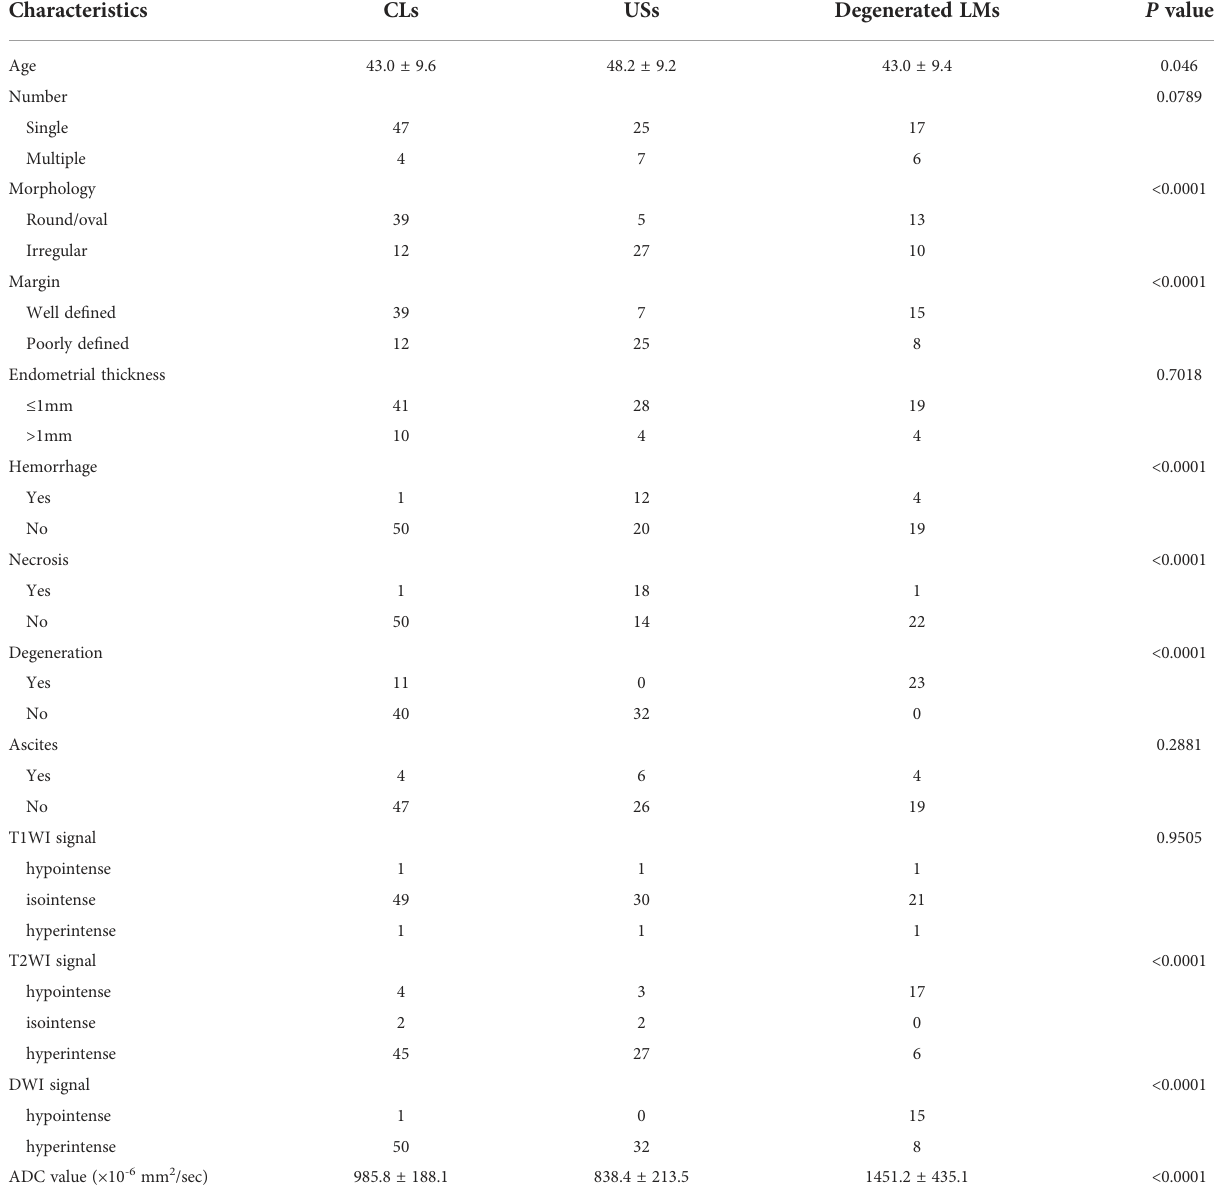
TABLE 1 Comparisons of clinical demographics, conventional MRI and DWI/ADC values among CLS, USs and degenerated LMs.